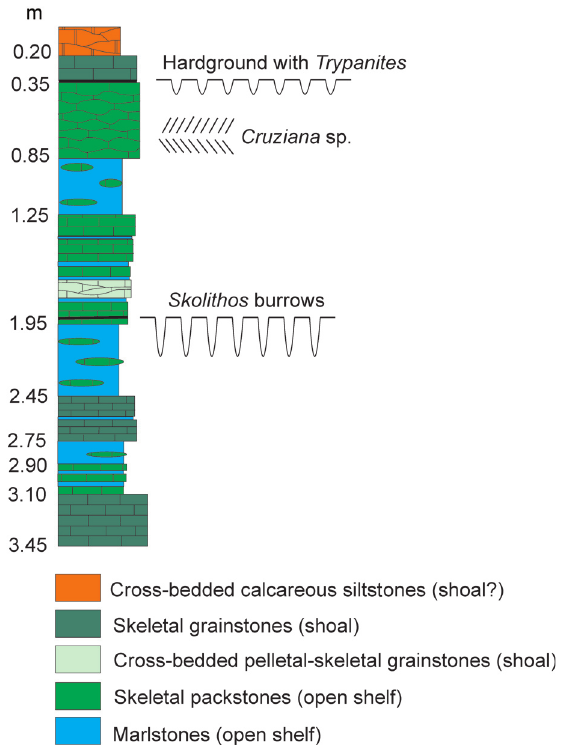
Fig. 2. Section of the Ohesaare cliff, Pridoli, Late Silurian (Modified after Vinn & Wilson 2010b).